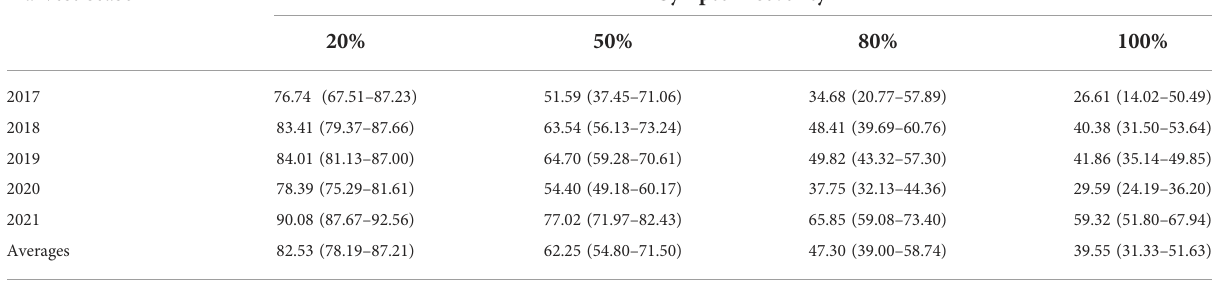
TABLE 2 Estimated averages and range of relative yield a of ‘ Femminello ’ lemon trees exhibiting variable severity levels of HLB leaf symptoms on the canopies, as projected by the negative exponential model shown in Figure 3 . Harvest